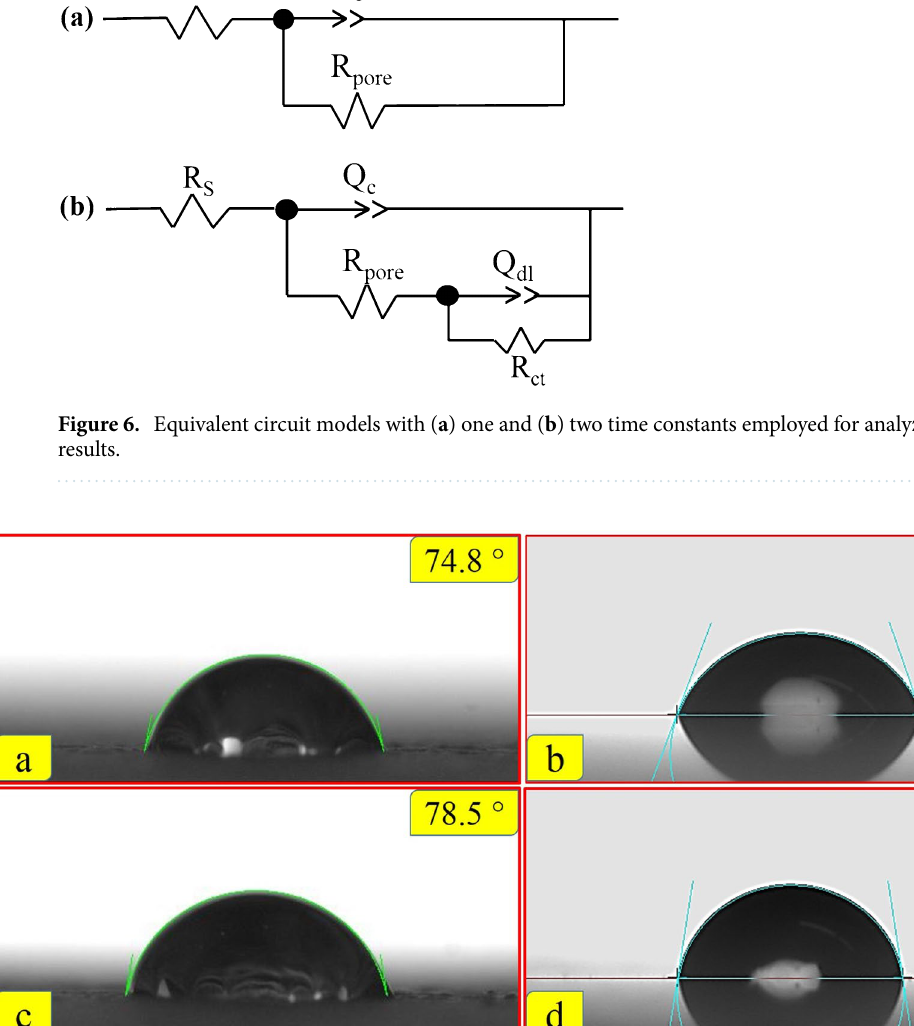
Figure 7. Contact angle measurements for the prepared coating samples: ( a ) pure epoxy, ( b ) UiO-66-NH 2 / epoxy, ( c ) CNTs/epoxy, and ( d ) composite (UiO-66-NH 2 /CNTs/epoxy)